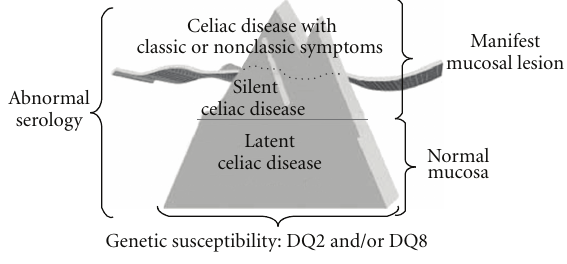
Figure 1: The celiac iceberg model